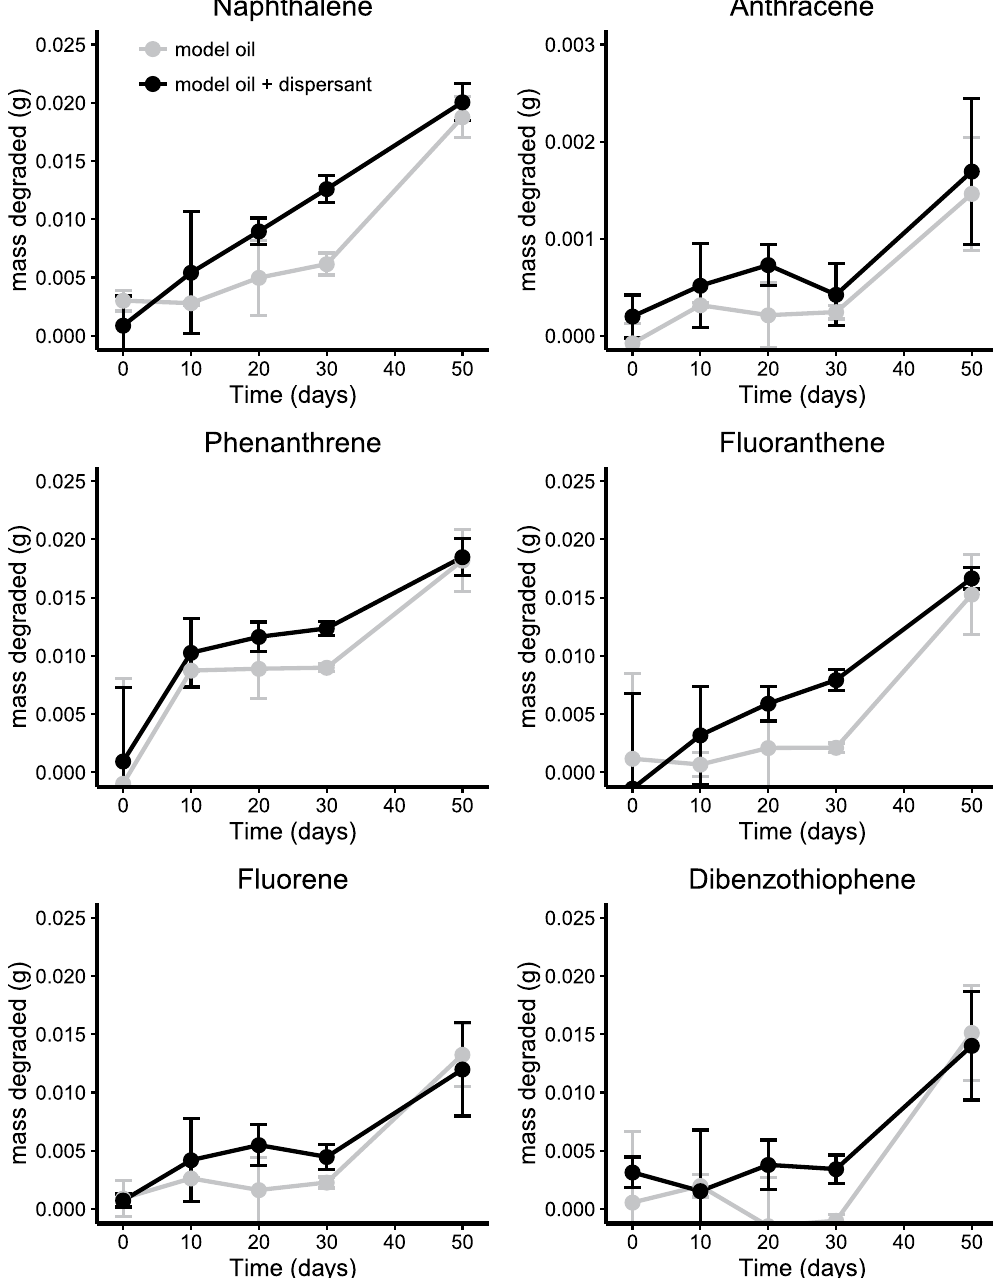
Figure 3. Mass of each PAH degraded during slurry incubations in FSC500 at 5 °C. Error bars are standard deviation, n = 3. Black lines are model oil and grey are model oil +